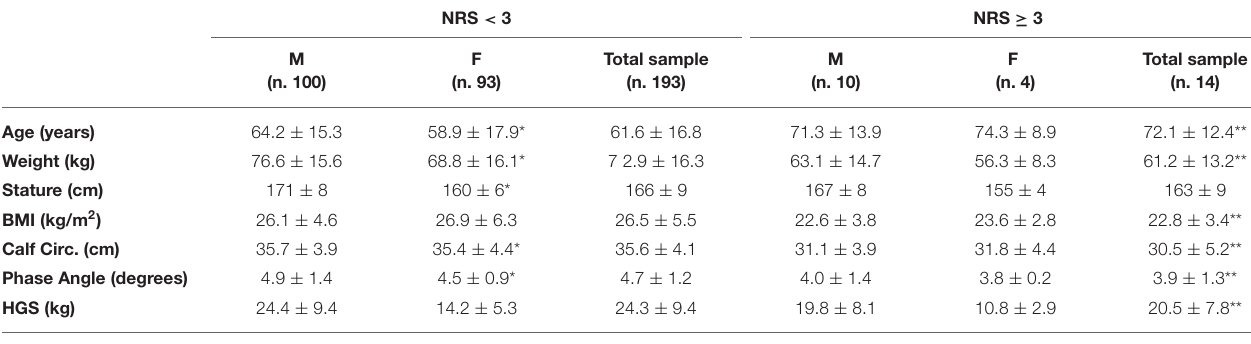
TABLE 3 | Anthropometric characteristics, body composition and handgrip strength according to NRS score in males, females and total sample.